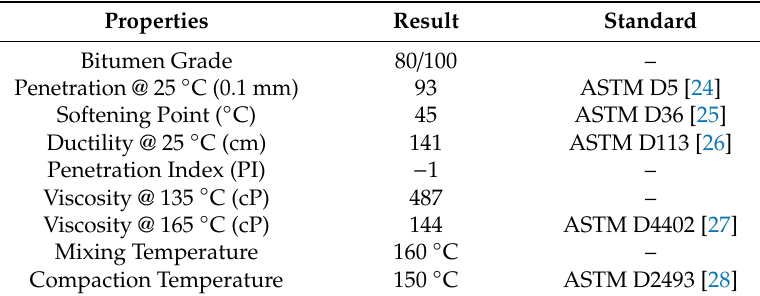
Table 1. The physical properties of the